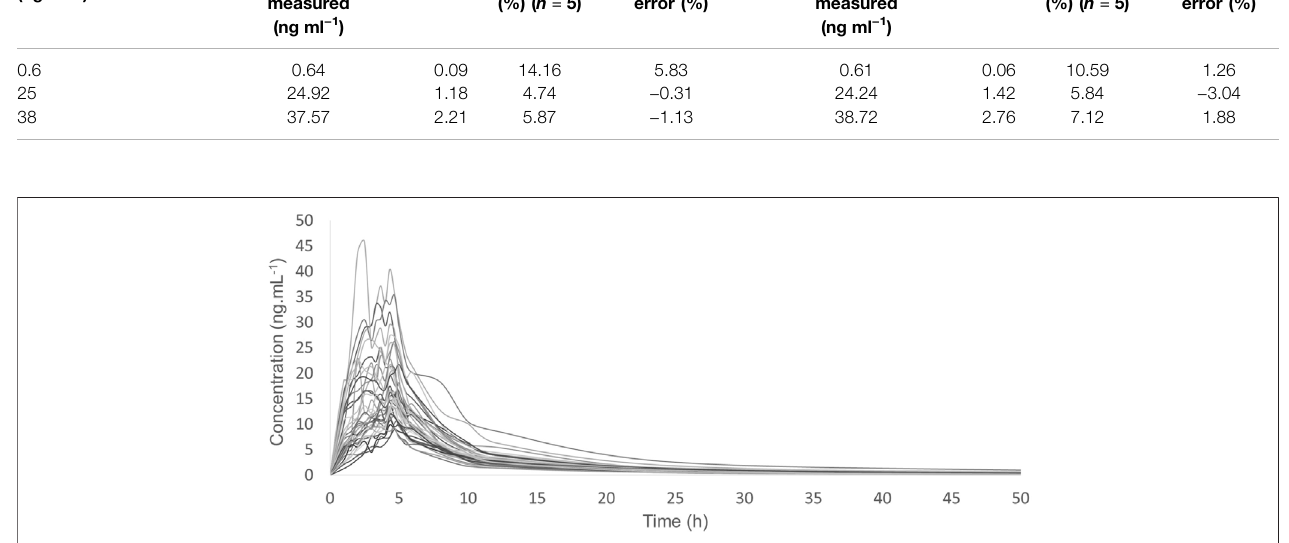
TABLE 2 | Precision and accuracy (analysis, spiking plasma samples at three different concentrations). Nominal concentration